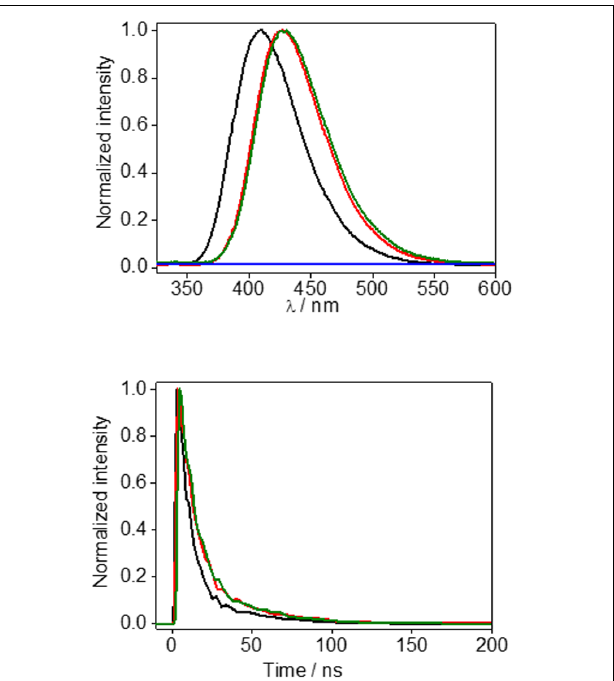
FIGURE 3 | (Top) Steady-state fluorescence ( λ exc = 308 nm) of phosphate buffer solution of HTB (black line), sunlight irradiated HTB-ubiquitin (1:1) after sephadex filtration (green line) or non-irradiated HTB-ubiquitin (1:1) after sephadex filtration (blue line), and HTB-butylNH 2 adduct (red line). (Bottom) Corresponding decays.